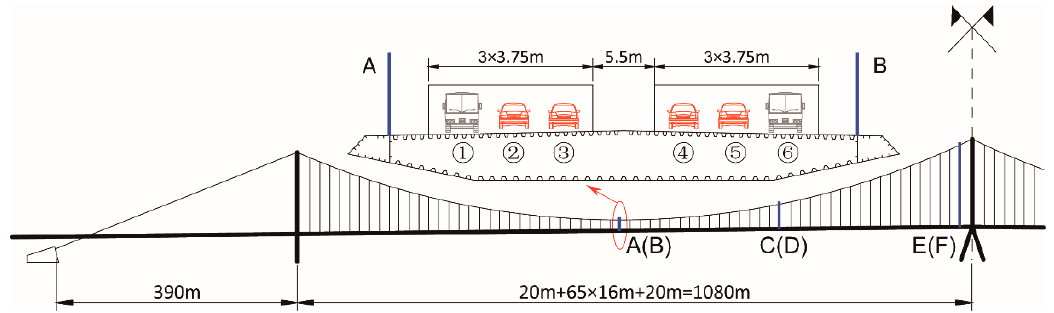
Figure 5. Elevation design and lane arrangement of Taizhou Yangtze River Bridge.